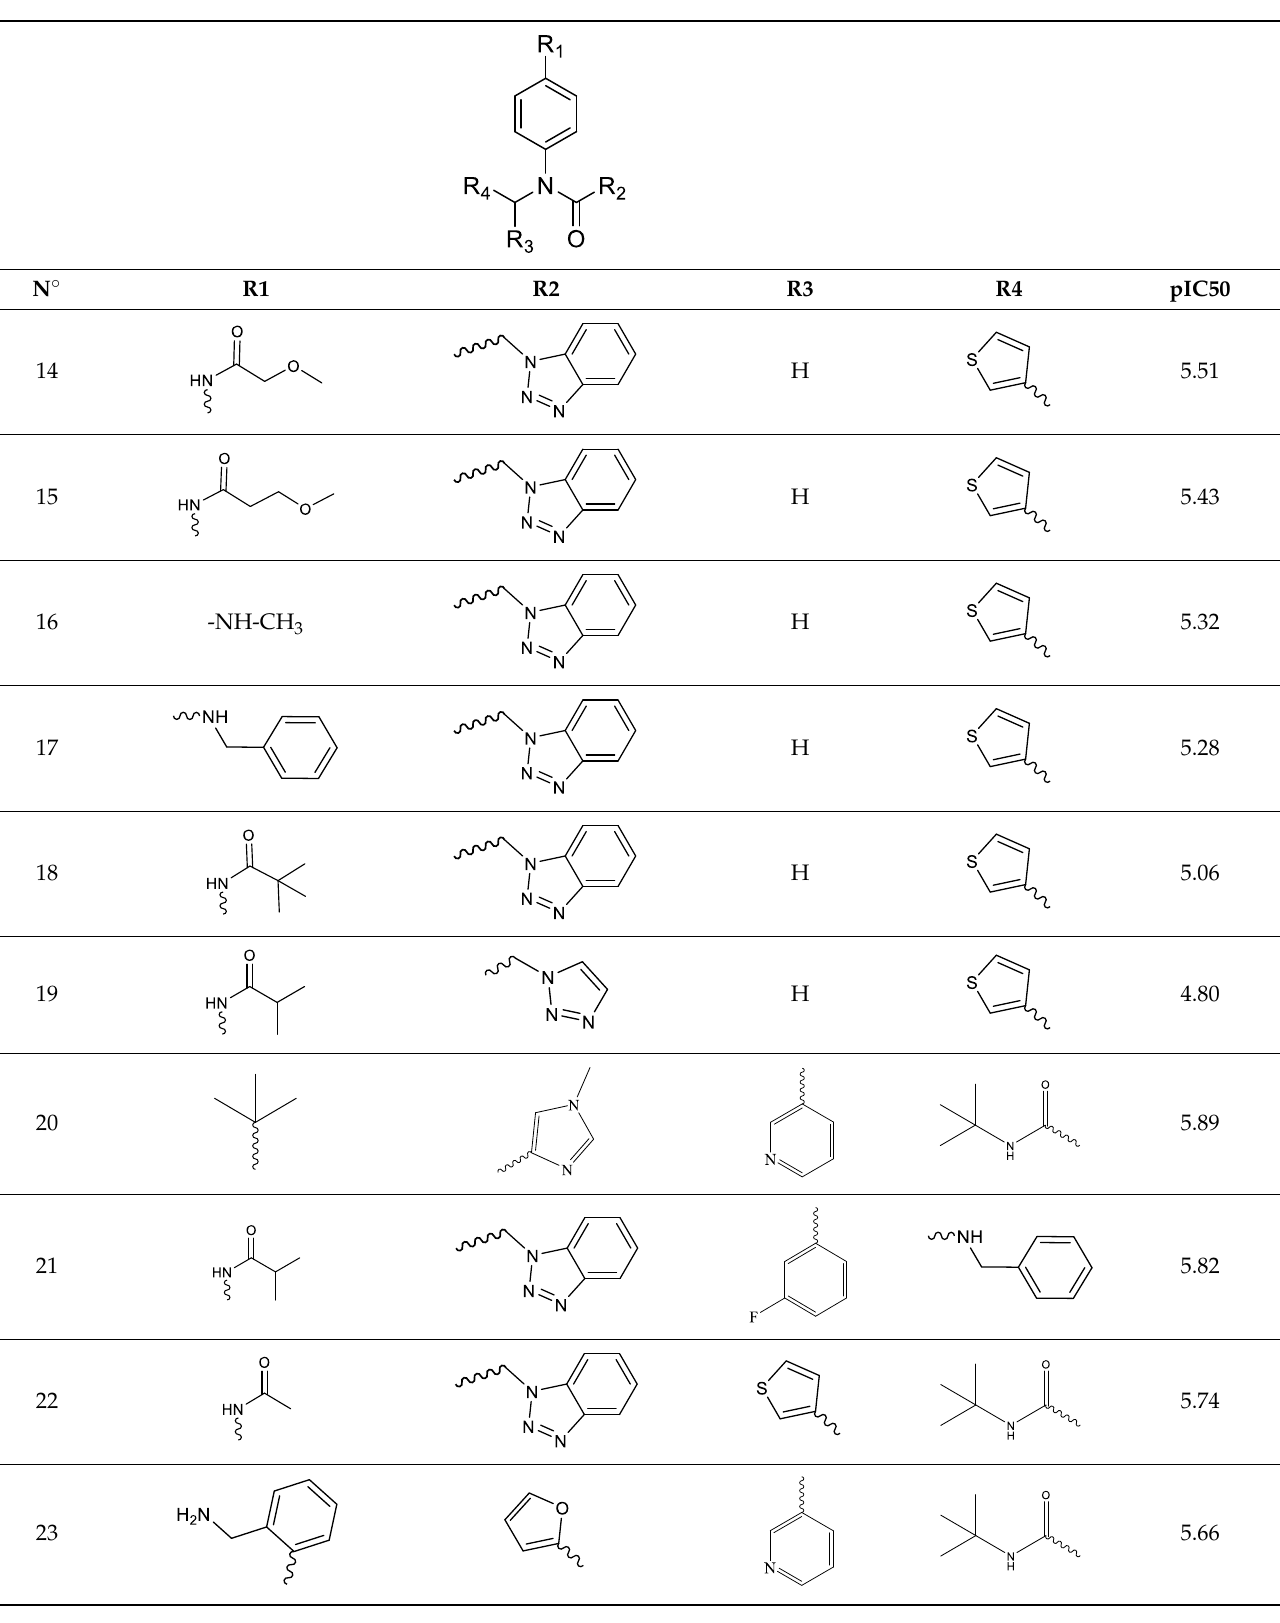
Table 1. Chemical structures and activity experiment of 41 peptidomimetic compounds.